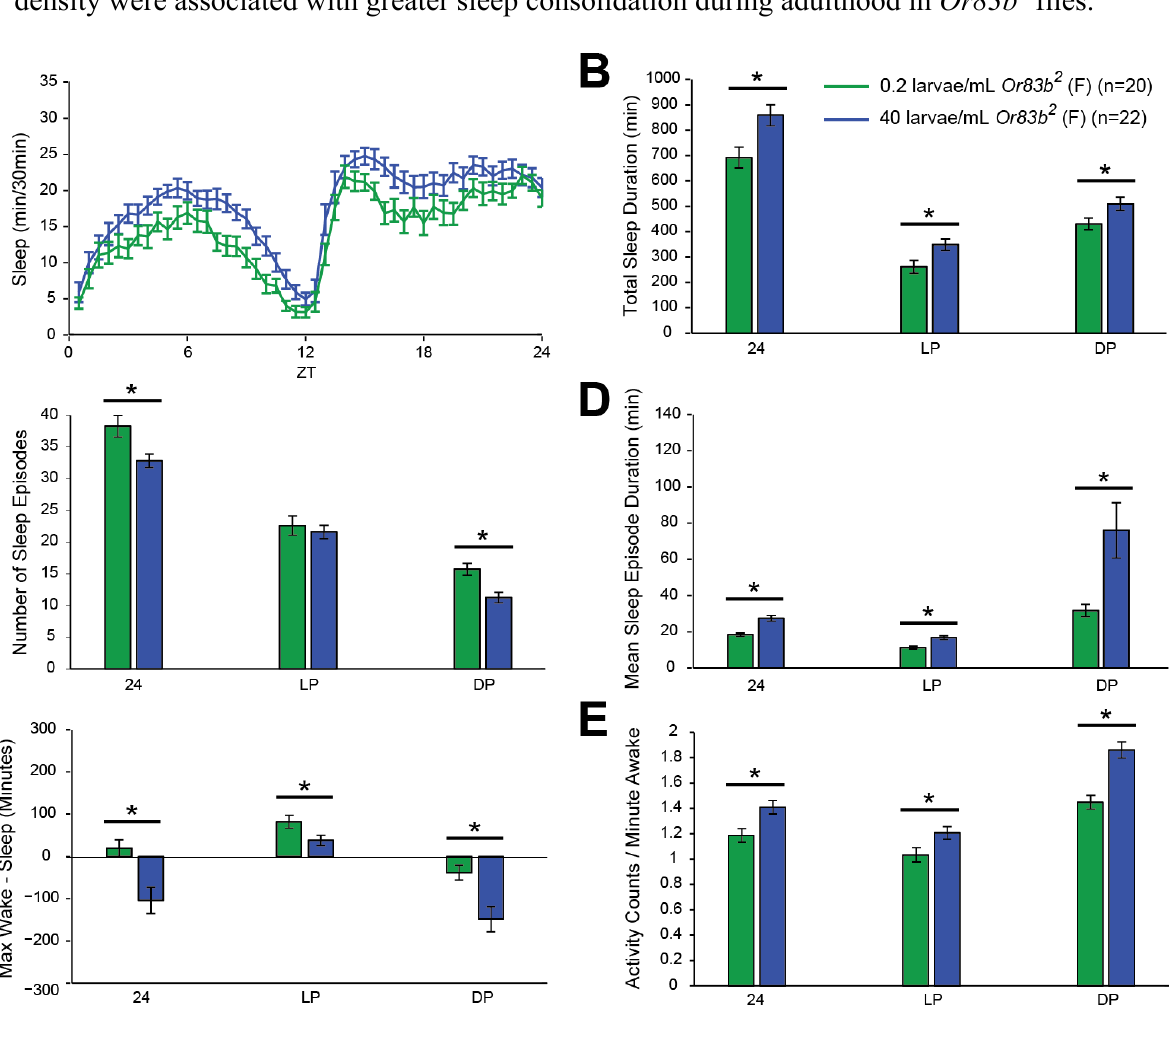
Figure 4. Increasing larval population density causes greater sleep consolidation in adult female fruit flies that lack the olfactory receptor or83b . ( A ) Minutes of sleep per 30-min bin, across an average day consisting of 12 h of light followed by 12 h of darkness (LD). Time after lights-on is indicated by zeitgeber time (ZT) on the X -axis. ( B – F ) Quantification of sleep parameters for the same average LD day, across all 24 h, across the light period (LP), or across the dark period (DP). Error bars represent the standard error of the mean. n represents the number of flies in each group. ( B ) Total sleep duration. ( C ) Number of sleep episodes. ( D ) Mean sleep episode duration. ( E ) A metric for relative stability of wake and sleep states, calculated by subtracting the duration of the longest sleep episode from the duration of the longest wake episode. Thus, positive values indicate that wakefulness was more consolidated than sleep, and vice versa . ( F ) Total number of beam crosses, or activity counts, per minute of wakefulness. As in wild-type CS flies, increases in larval population density were associated with greater sleep consolidation during adulthood in Or83b 2